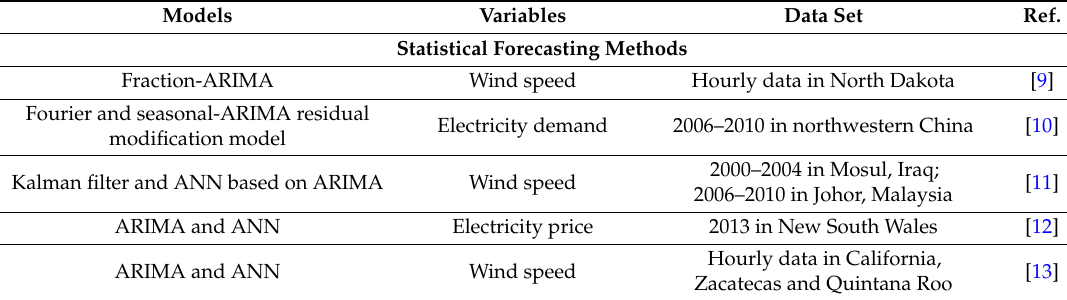
Table 1. Summary of forecasting